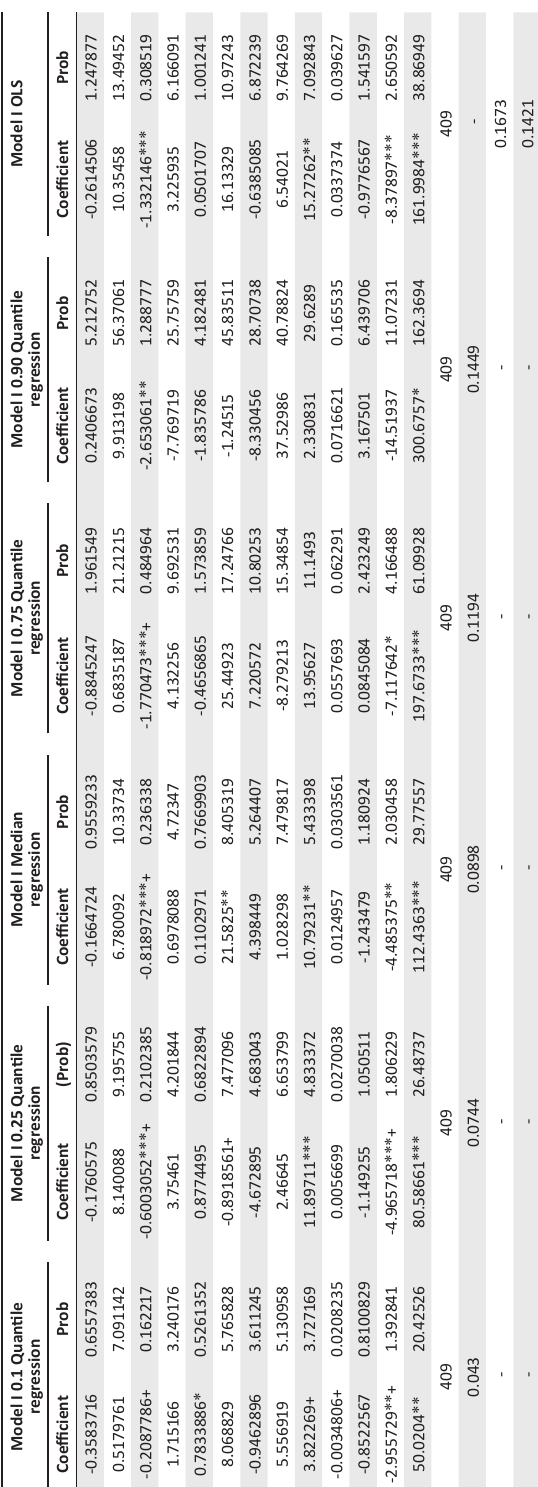
TABLE 3: Coding for variables used in the full regression model. Variable Dummy/ categorical variable